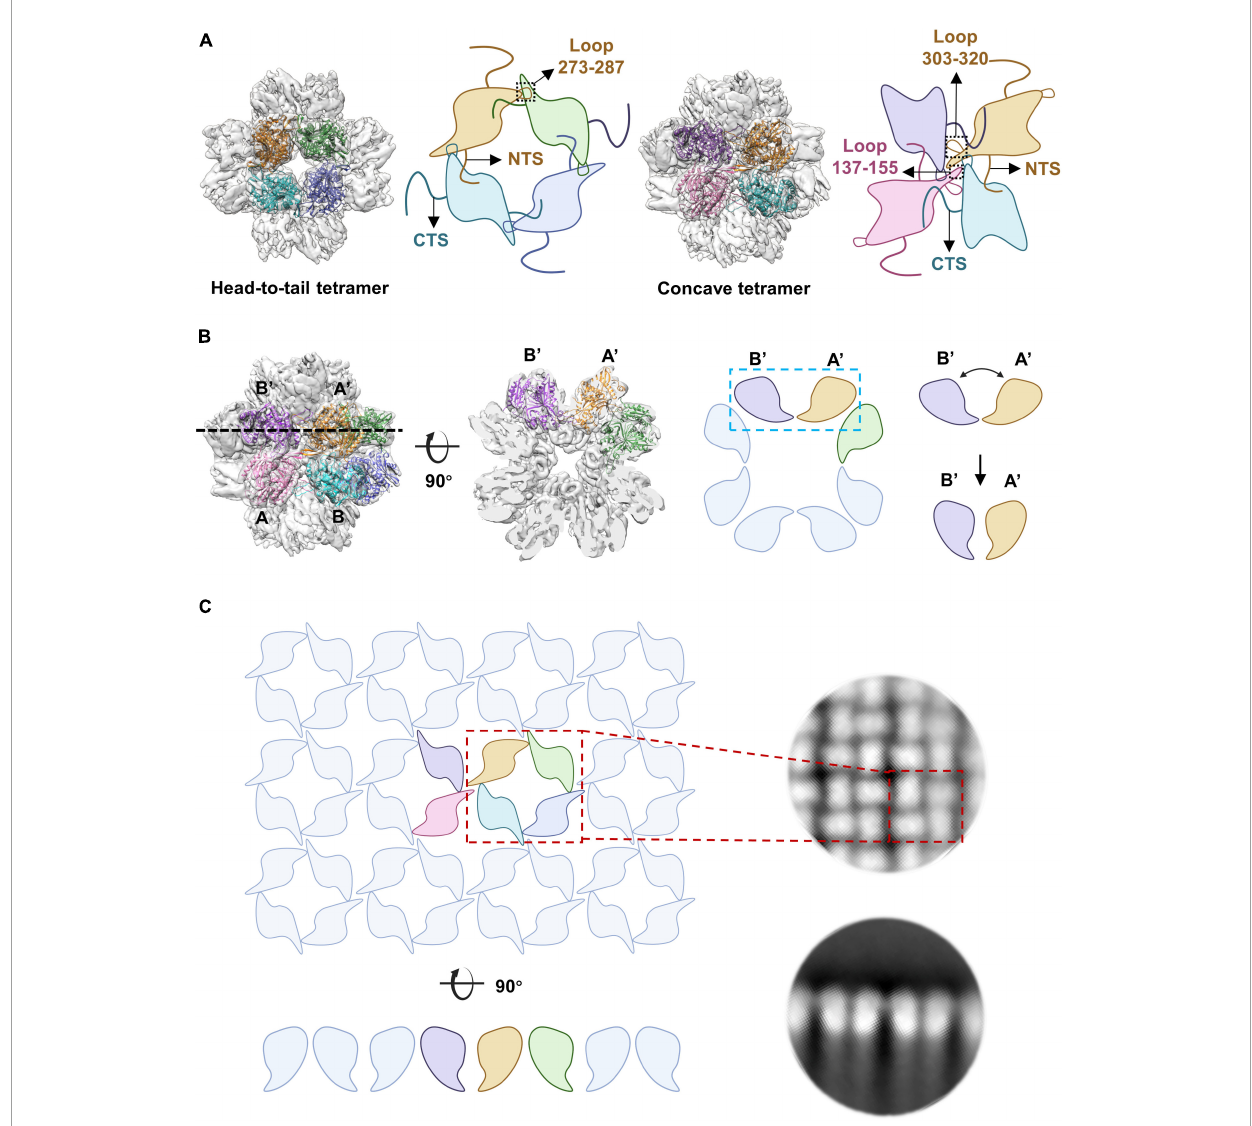
FIGURE7 The arrangement of gp105 in the nucleus-like shell. (A) Schematic diagrams showing the contacts in the head-to-tail and concave tetramers. ( B , Left) Surface rendered representations and ribbon diagrams showing the cube-like assembly of gp105 and its cross-section. Each monomer of the fitted head-to-tail and concave tetramers are colored differently. Right: schematic diagrams showing the side view of the concave tetramer and its deformation into the arrangement required for the formation of the lattice-like structure, through the change of the bending angle between AB’ and A’B. (C) Schematic diagrams showing the organization of gp105 in the lattice-like structure. Right is the 2D class averages of the highly aggregated gp105 eluted at the void volume of